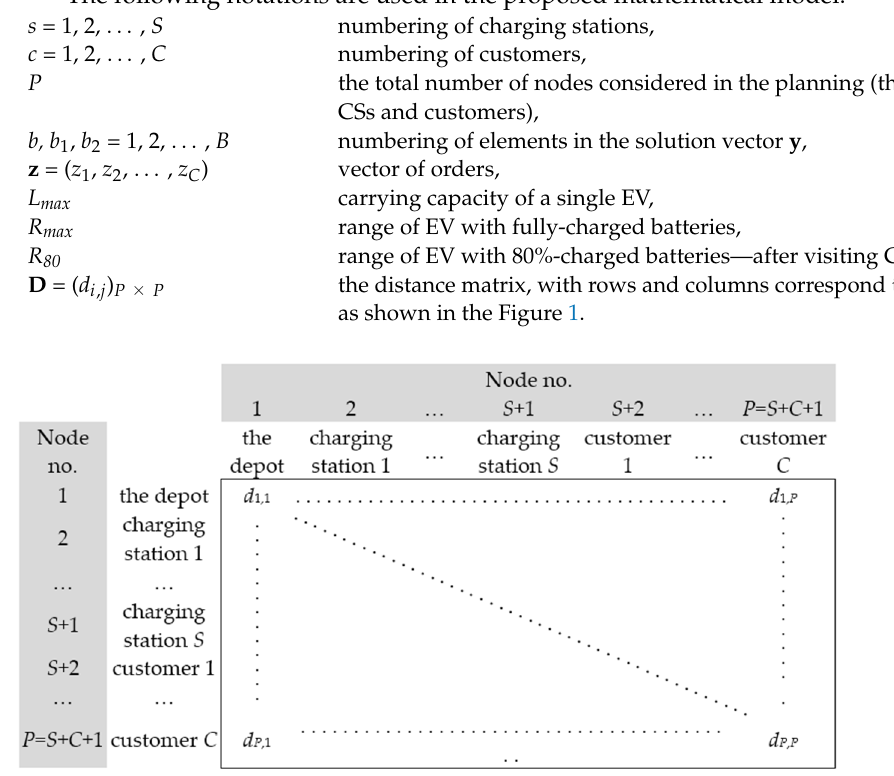
Figure 1. The structure of distance matrix